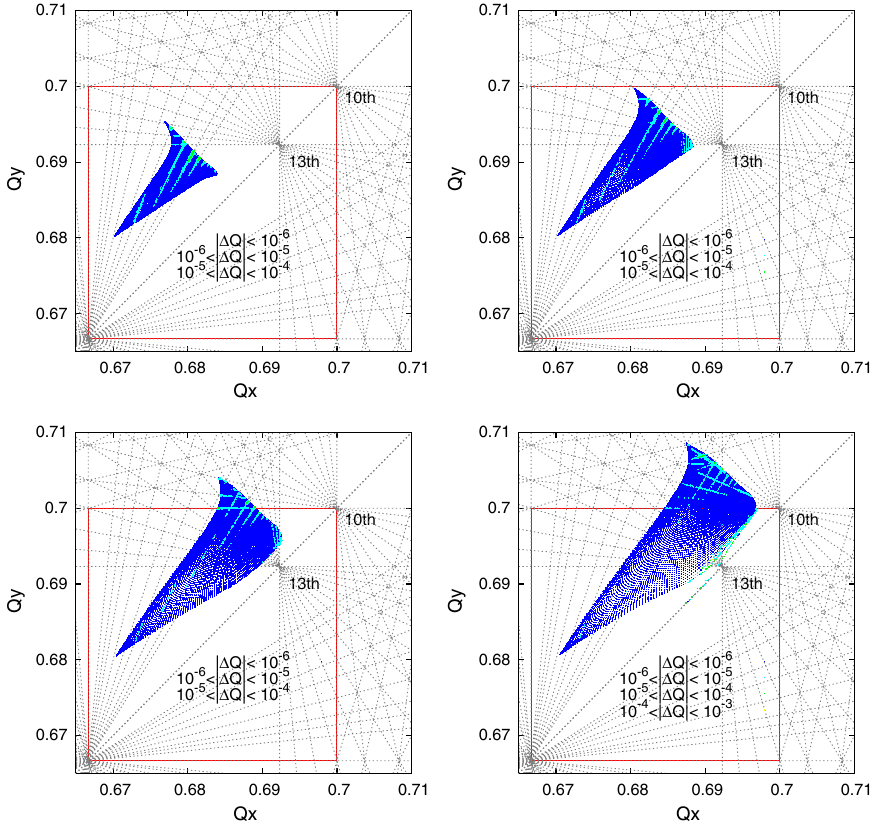
FIG. 4. Tune footprints and tune diffusion without beam-beam compensation. The proton beams collide at IP6 and IP8. The bunch intensities are 1 : 5 (cid:2) 10 11 (top left), 2 : 0 (cid:2) 10 11 (top right), 2 : 5 (cid:2) 10 11 (bottom left), and 3 : 0 (cid:2) 10 11 (bottom